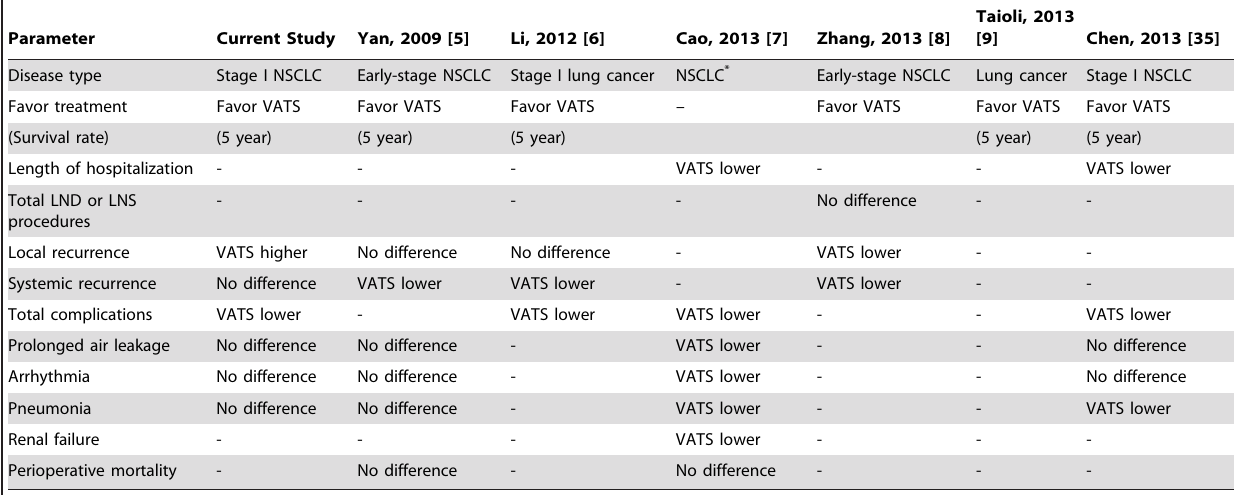
Table 2. Comparison with prior